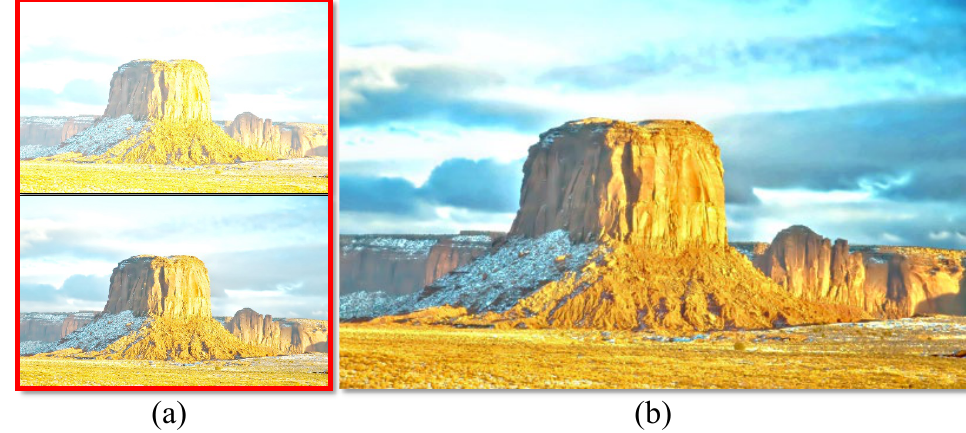
Figure 1. An example of the proposed two-exposure image fusion. ( a ) An input image pair with two exposures. ( b ) The fused image using the proposed